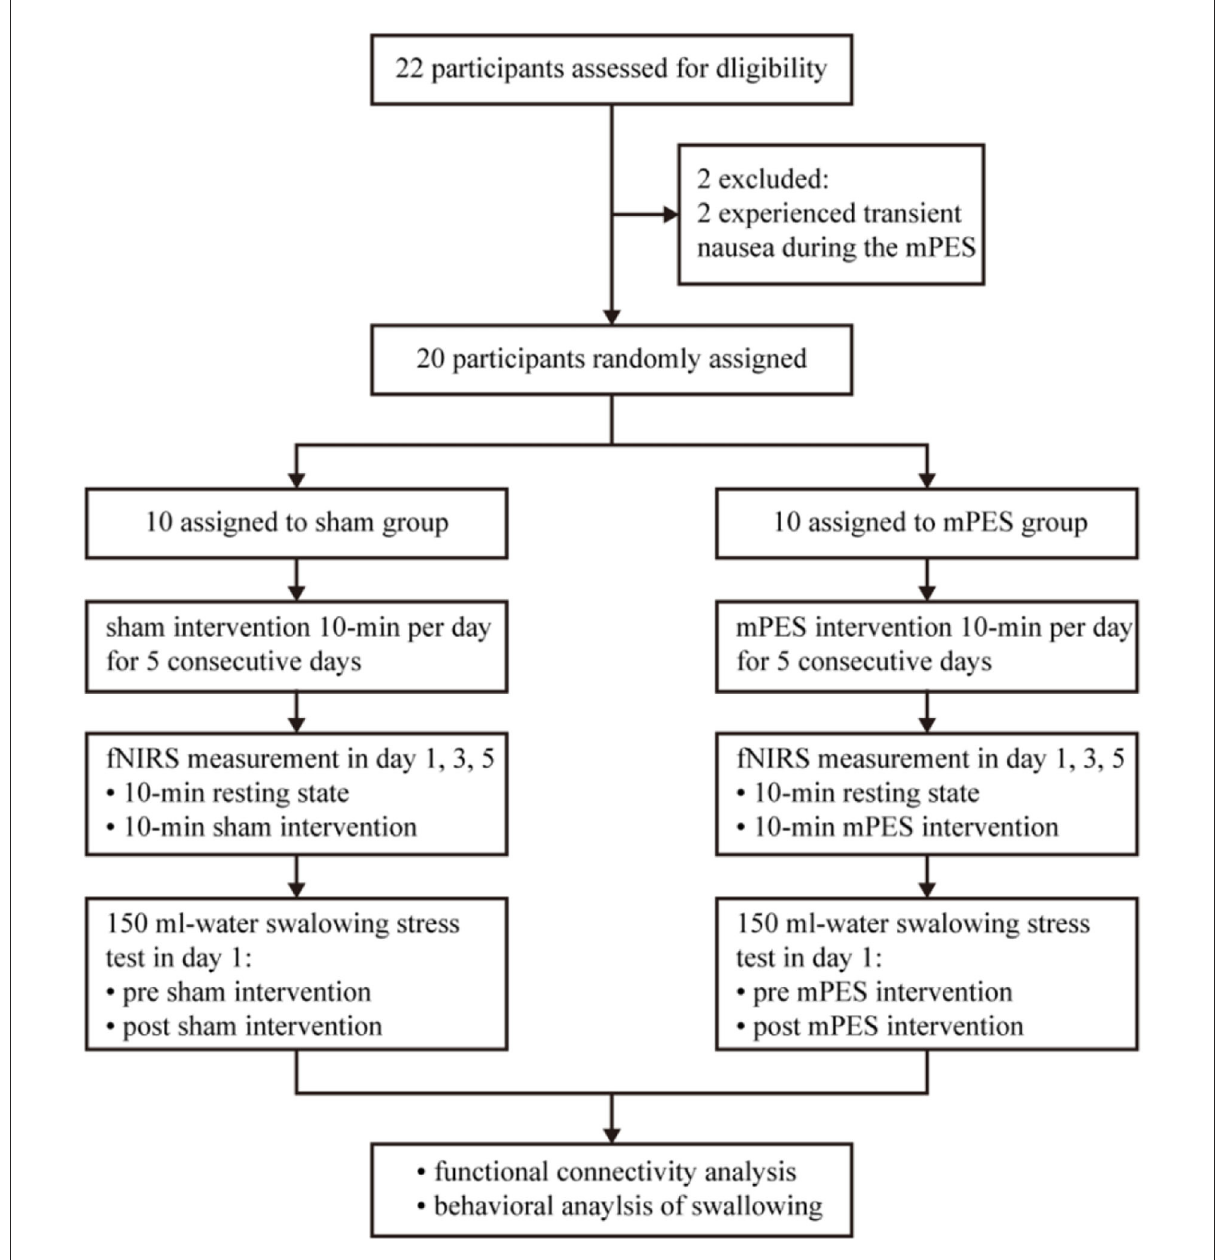
FIGURE1 Flow diagram of the trial. mPES, modified pharyngeal electrical stimulation; fNIRS, functional near-infrared spectroscopy.